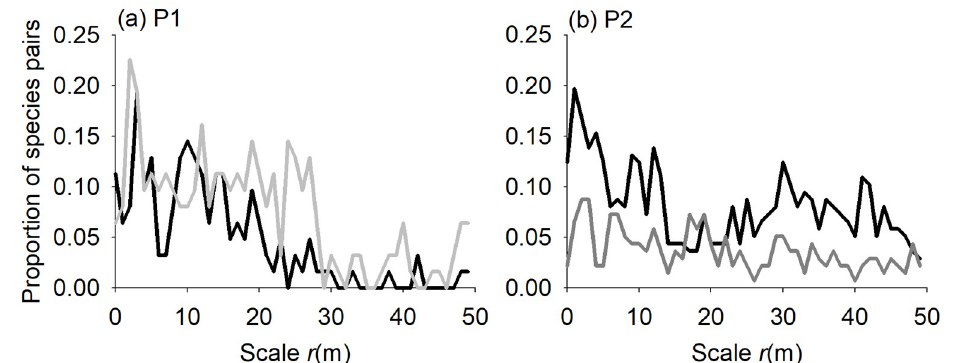
Figure 3. Significant heterospecific associations analyzed by the bivariate pair‐correlation function g 12 ( r ) from 199 Monte Carlo simulations at p values ≤ 0.05. The null models were independence at P1 ( a ), and pattern 1 fixed and pattern 2 randomized by inhomogeneous Poisson process at P2 ( b ). Black lines indicate attraction, grey lines indicate repulsion.